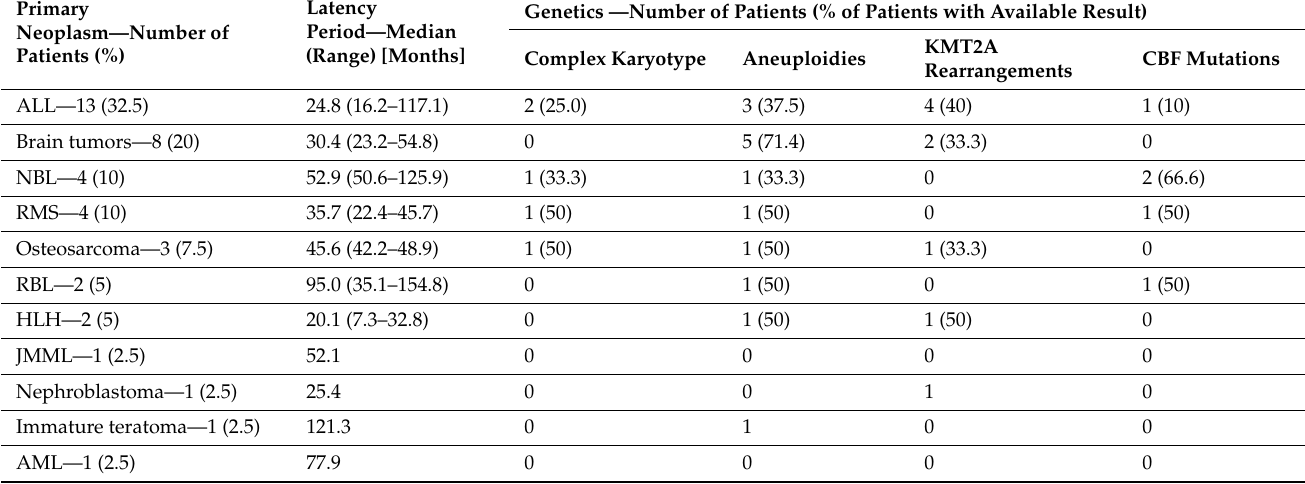
Table 3. Latency period and genetics depending on primary malignancy.